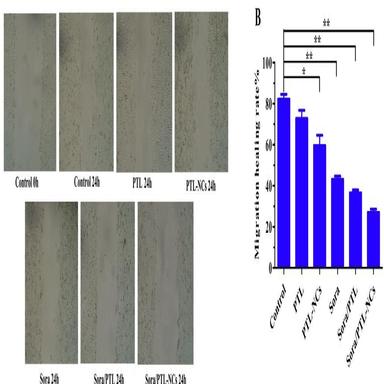
(A) The antimigration activity of different treatments in HepG2 cells after incubated for 24 h. (B) The migration healing rate of different treatments in HepG2 cells after incubated for 24 h. Data are presented as mean ± SD (n = 3). \ means p < 0.05, \\ means p < 0.01.